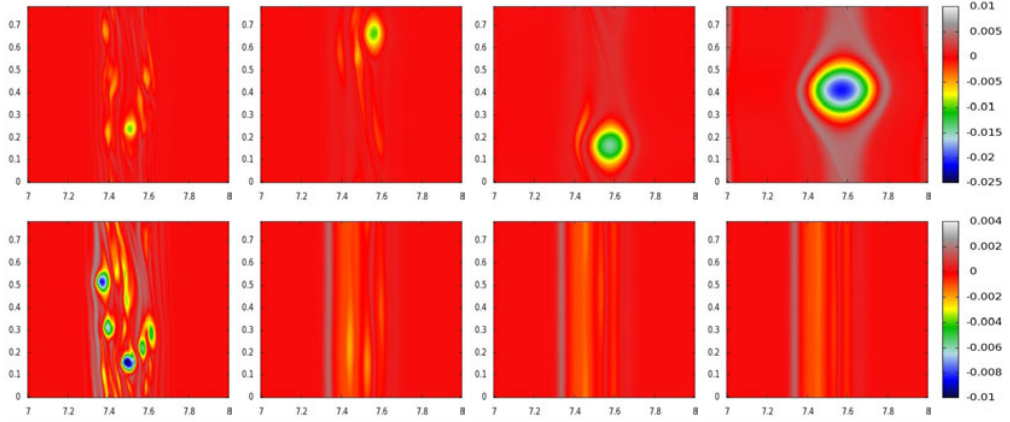
Figure 1. Vorticity map for N 2 < 0 (top) and N 2 > 0 (bottom) after 20, 200, 400 and 600 rotations,